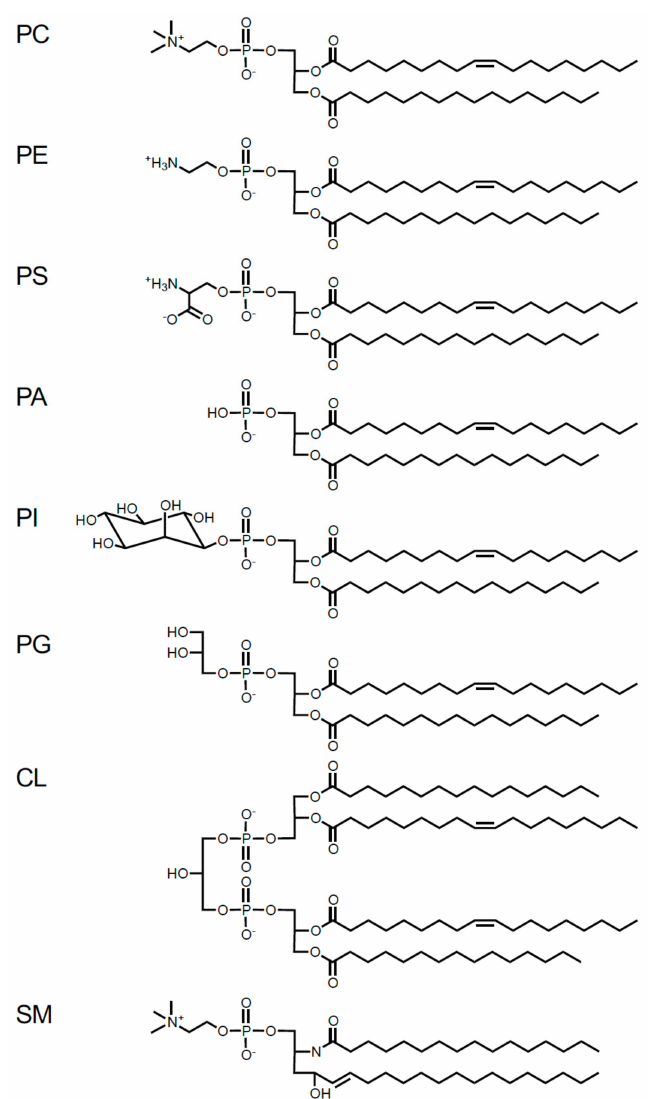
Figure 1. Structures of the phospholipid classes, phosphatidylcholine (PC), phosphatidylethanolamine (PE), phosphatidylserine (PS), phosphatidic acid (PA), phosphatidylinositol (PI), phosphatidylglycerol (PG), cardiolipin (CL), and sphingomyelin (SM). These phospholipid molecules contain various acyl